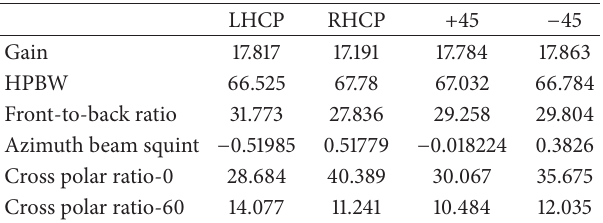
Table 1: Comparison of pattern performance between linear polar- ized antenna and circular polarized antenna.